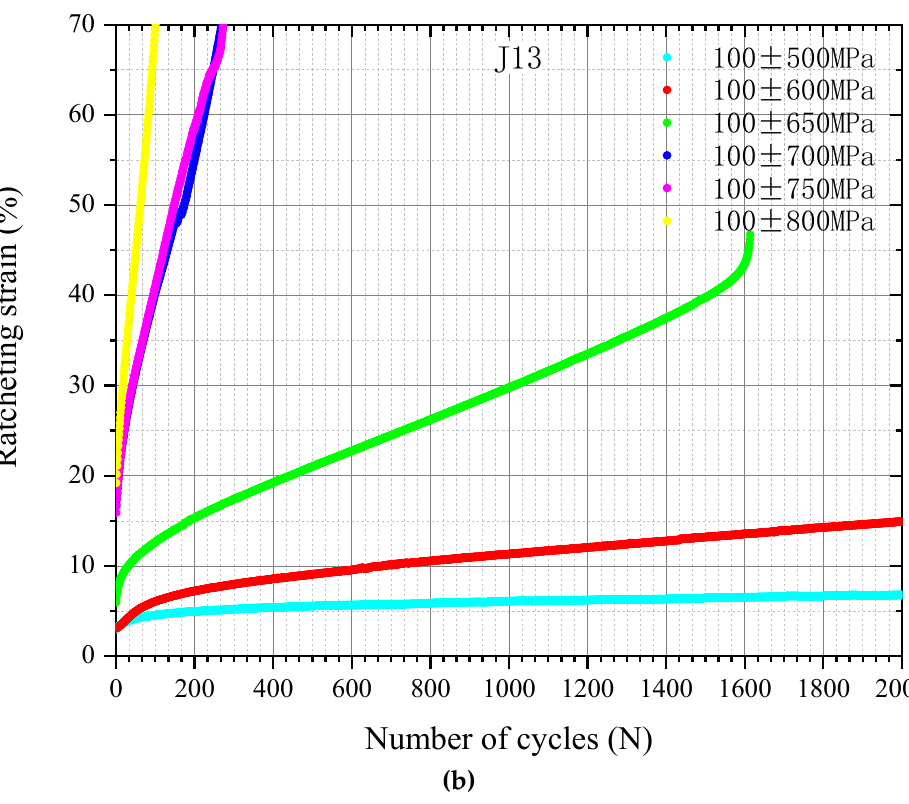
Figure 7. Ratcheting evolution curve for the following wheel steels: ( a ) J12; ( b ) J13.